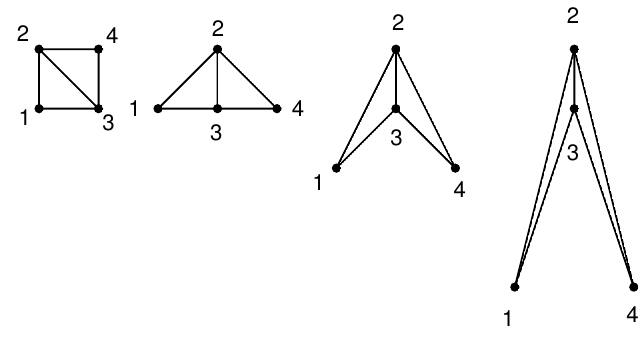
Figure 3 . Quadrilaterals in a triangulation of a polygon P